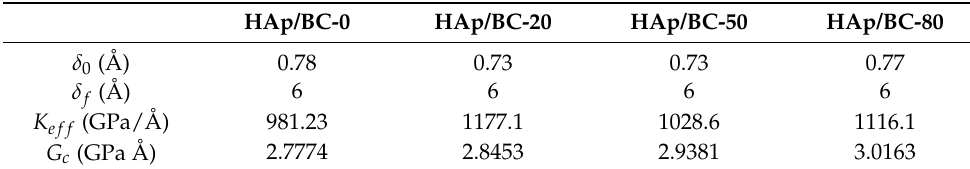
Table 3. Parameters of the interface separation (i.e., 85% of the BC constraint), for the opening- mode test.